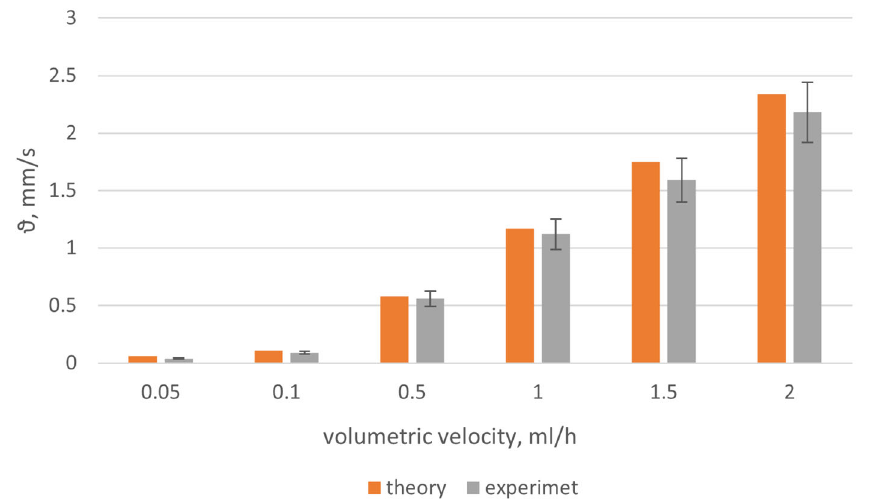
Figure 10. The results of the study of model fluid flow velocity ϑ .